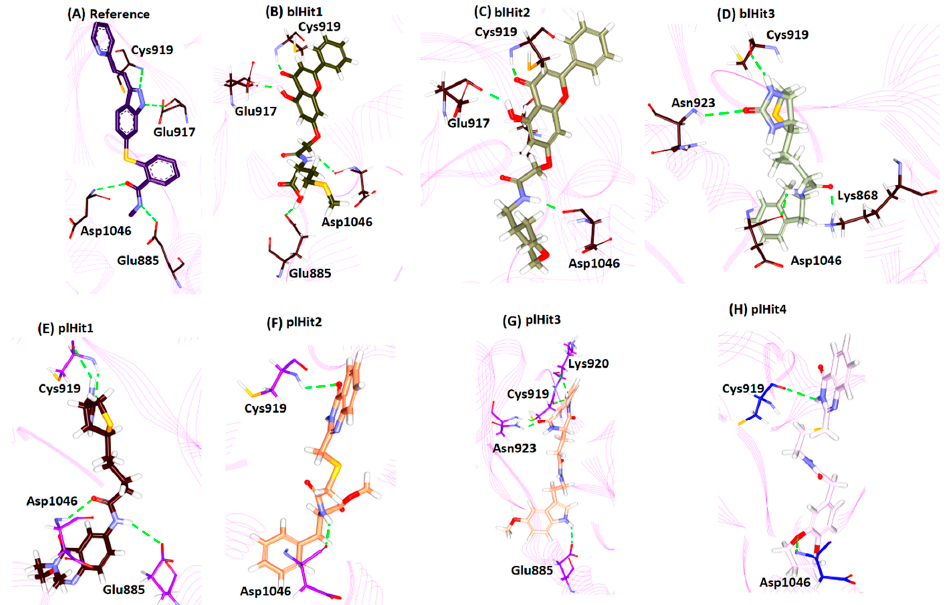
Figure 5. Intermolecular hydrogen bond interaction of the protein-hit compounds in comparison with the reference. ( A ) Intermolecular hydrogen bond interactions of the reference compound; ( B ) Hydrogen bond interactions of the blHit1; ( C ) Hydrogen bond interactions of the blHit2; ( D ) Hydrogen bond interactions of the blHit3; ( E ) Hydrogen bond interactions of the plHit1; ( F ) Hydrogen bond interactions of the plHit2; ( G ) Hydrogen bond interactions of the plHit3; ( H ) Hydrogen bond interactions of the plHit4. Green dotted line represent the hydrogen bond interactions.